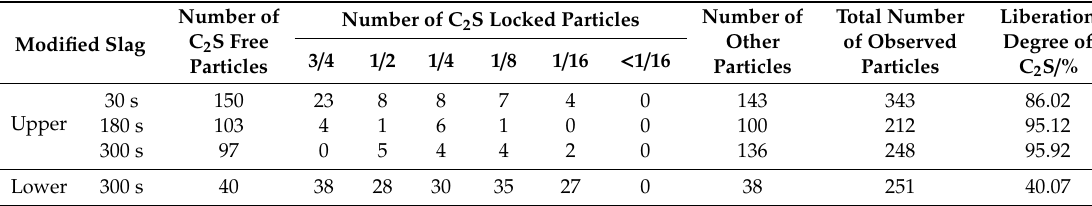
Table 6. Liberation degree of C 2 S in the upper and lower modified